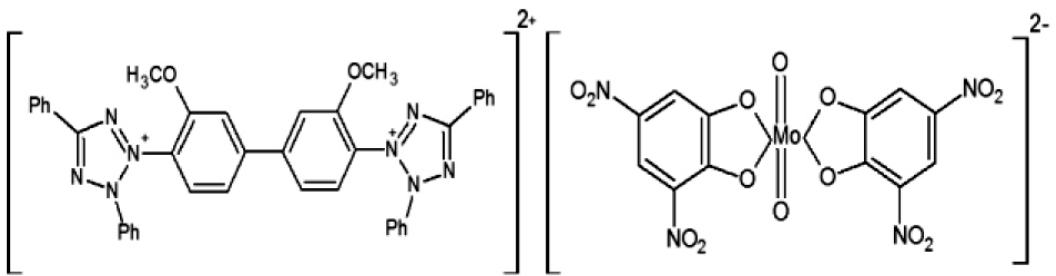
Figure 6. Structure of the complex